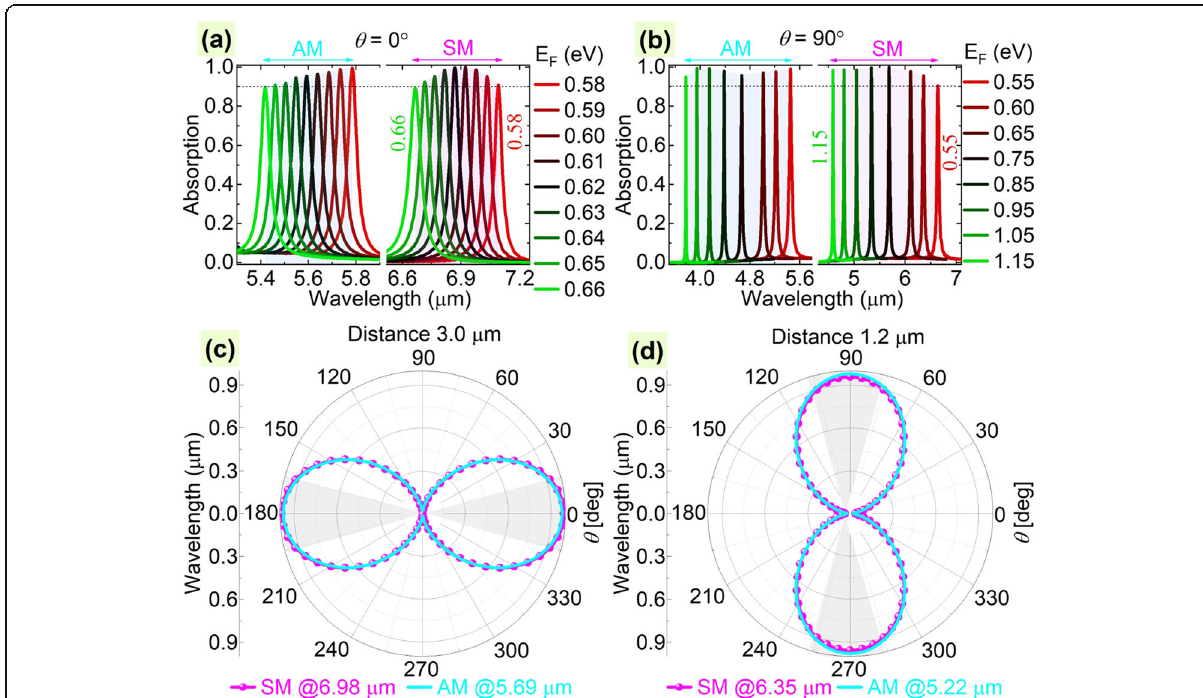
Fig. 6 Absorption spectra with different Fermi energy levels of graphene at polarization angles of θ = 0° ( a ) and 90° ( b ) for the cases with a metal substrate below the LGNRs with a distance of 3.0 μ m ( a , c ) and 1.2 μ m ( b , d ), respectively. ( c , d ) Absorption maxima as functions of θ . SM and AM refer to the symmetric mode and antisymmetric mode,